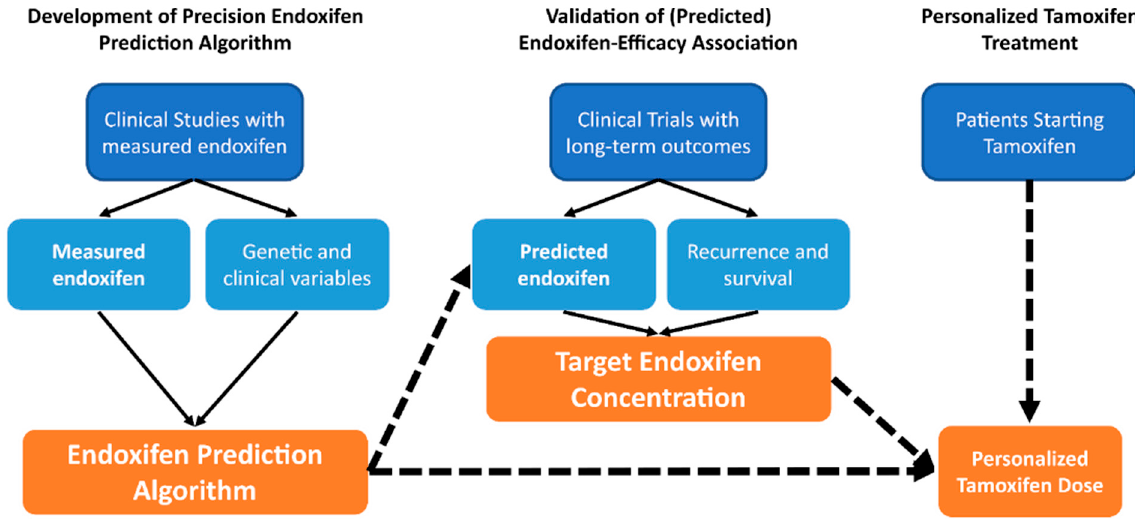
Figure 3. Approach for generating a precision endoxifen prediction algorithm to enable personalized tamoxifen dosing. A precision endoxifen prediction algorithm that integrates clinical and genetic variables could be generated from existing datasets. The algorithm would then be used to validate the association of endoxifen concentration with tamoxifen efficacy and identify the target endoxifen concentration. This information could then be used to inform personalized dosing that maximizes tamoxifen treatment efficacy.